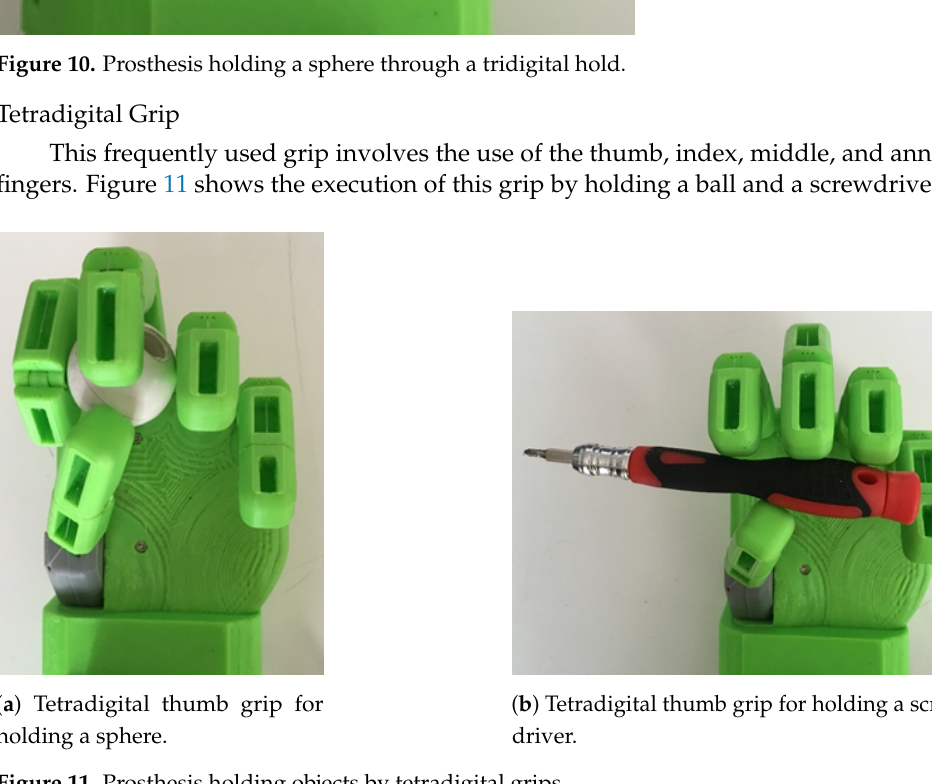
Figure 11. Prosthesis holding objects by tetradigital